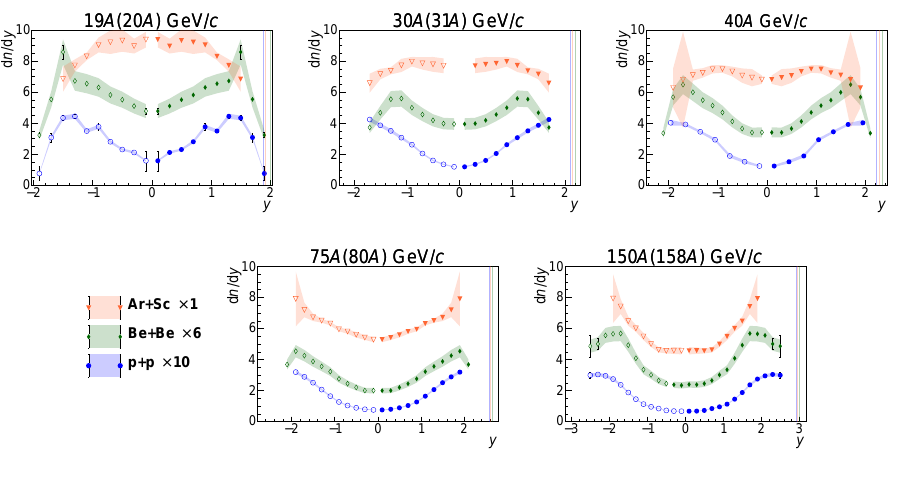
Figure 2: Rapidity spectra of protons produced in inelastic p + p and central Be + Be and Ar + Sc (preliminary results) collisions at beam momenta in range 19 A (20 A ) − 150 A (158 A ) GeV / c . See Sec. 4 for more details.